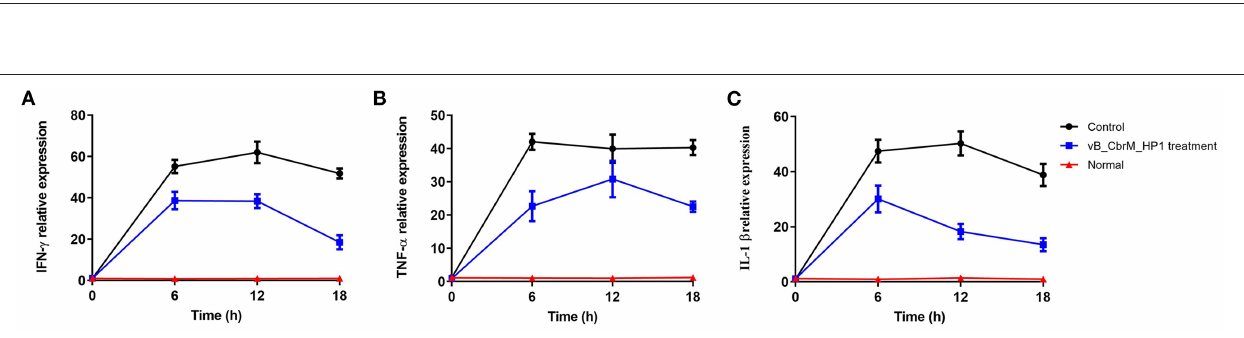
FIGURE 7 | Cytokine levels. The fish were injected intraperitoneally with Cbr-1 (2 × 10 9 CFU/fish). One hour later, vB_CbrM_HP1 (10 9 PFU/fish) or PBS was introduced intraperitoneally. (A) The transcription levels of the intestinal cytokines IFN- γ , (B) TNF- α and (C) IL-1 β were detected by qPCR at 6, 12 and 18h after vB_CbrM_HP1 phage treatment. The experiment was repeated three times. Each data point is expressed as the mean ± SD from three biological experiments.